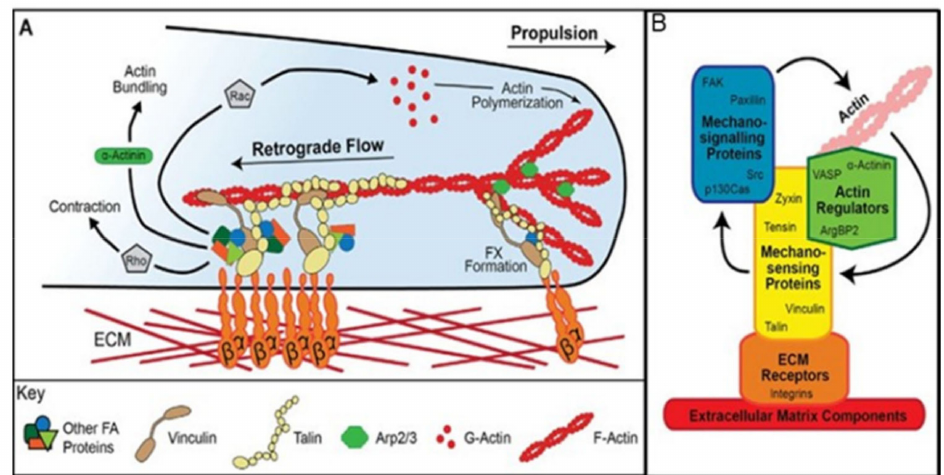
Figure 7. Integrin-based models of mechanotransduction which could operate in muscle satellite cells. ( A ) In the clutch model for SC migration, actin polymerisation at the advancing leading edge of the cell generates a retrograde flow of F-actin. Talin and vinculin both engage with the retrograde flow of actin, which generates tensional forces across them, regulating their activation states. Talin and vinculin bind to several signalling proteins including focal adhesion kinase, paxillin and others, producing downstream signalling events regulating the activity of the Rho-family GTPases. Vinculin can also induce actin bundling, acting through α -actinin. The activation state of talin and vinculin regulates their dynamic turnover, as well as influencing the molecular stoichiometry of the adhesion to direct downstream signalling to Rho-family GTPases. Rho activation leads to greater contractility and FA growth, whereas Rac activity enhances actin polymerisation at the leading edge. The growth of new actin filaments also leads to the formation of focal complexes (FXs), which can mature into larger focal adhesions, which act locally to control intracellular signalling. The sensing of